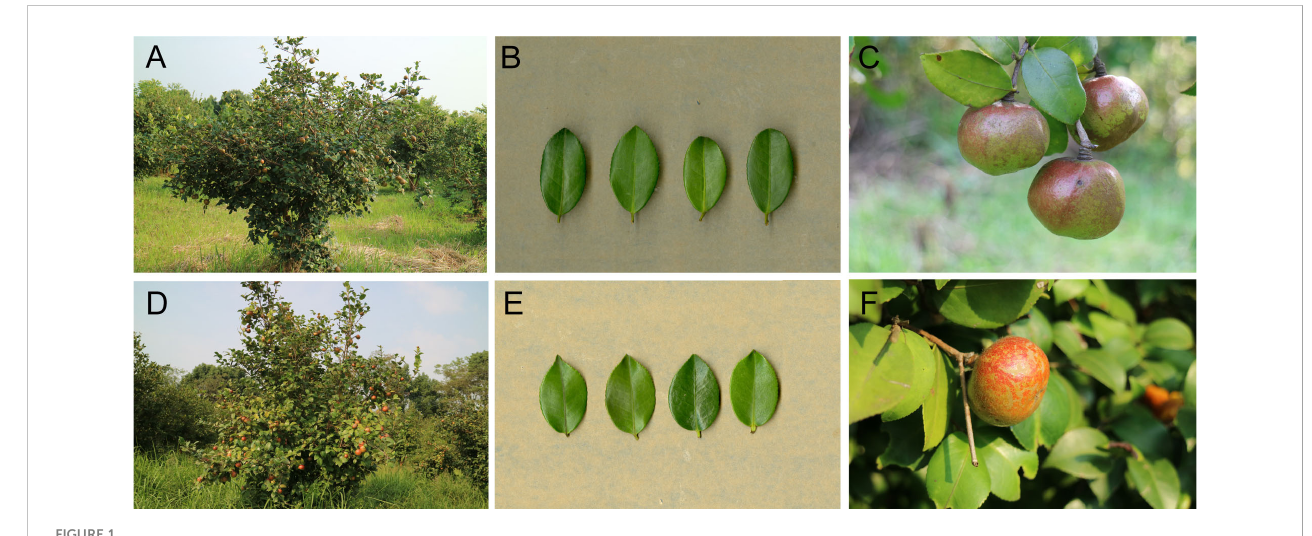
FIGURE 1 Trees, leaves, and fruits of HS (A – C) and HX (D – F)